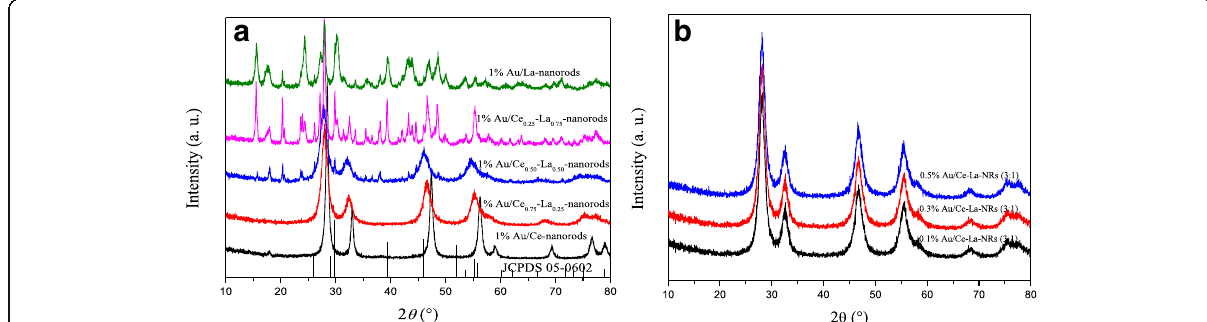
Fig. 2 XRD patterns of 1% Au/Ce-La nanorods with different La contents (0 – 100 at.%) ( a ) and Au/Ce 0.75 -La 0.25 nanorods with different Au loadings calcined at 300 °C for 2 h ( b